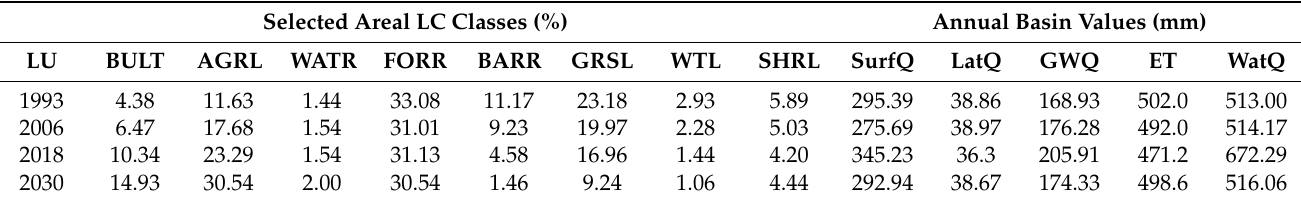
Table 4. Area land use change, annual basin values (mm) for different consecutive years in the study area (note: glacier and rocky surface ice were excluded in this